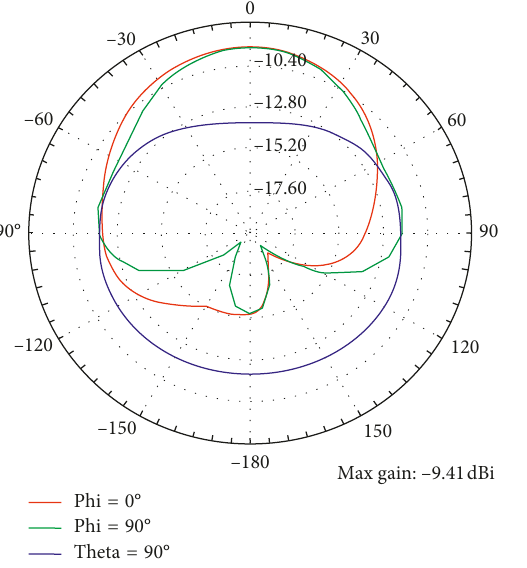
Figure 16: Radiation pattern (total gain) of the epidermal tag with meandered lines in two directions.